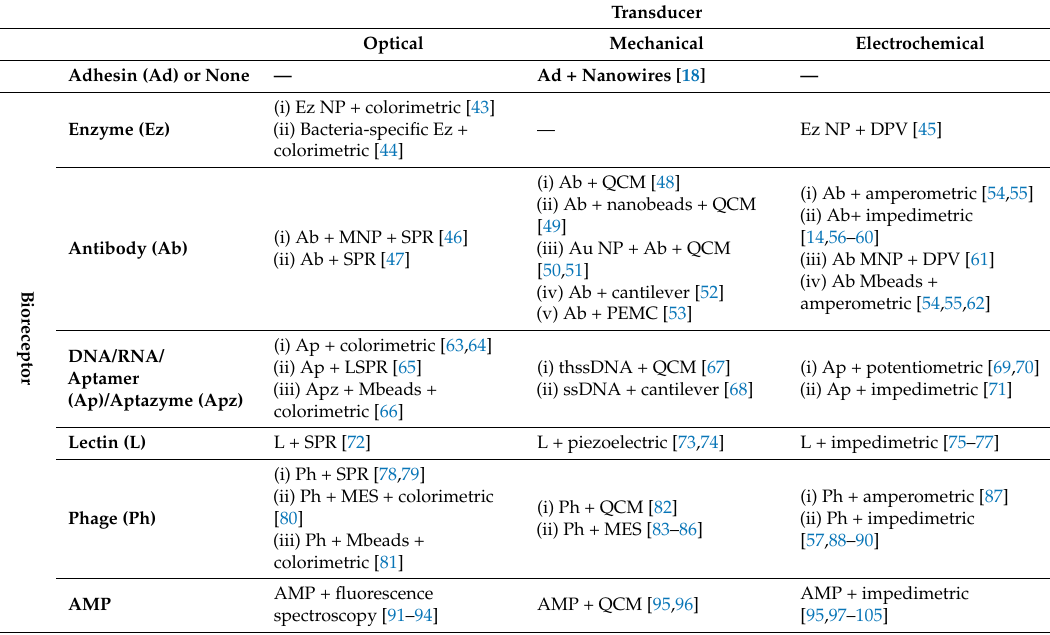
Table 1. Examples of different combinations between biorecognition elements and transducers to obtain biosensors for bacterial